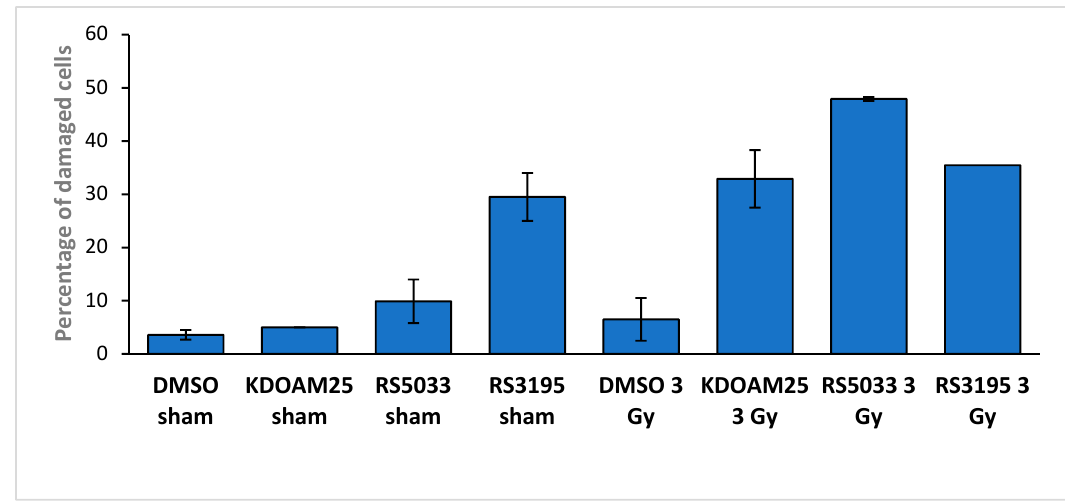
Figure 6. KDM5 enzymes inhibitors increase DNA damage accumulation in irradiated breast cancer cells. The histograms report the % fraction of MCF-7 cells showing a tail long at least as the head diameter in the described conditions. Concentrations were: 3 µ M for RS3195 and RS5033 and 0.3 µ M for KDOAM-25. DMSO concentration was 0.1% in all samples Data are the average of two independent experiments, variability is indicated (number of observed cells: DMSO sham 54; KDOAM-25 sham 40; RS5033 sham 44; RS3195 sham 98; DMSO 3 Gy 51; KDOAM 3 Gy 68; RS5033 3 Gy 50; RS3195 3 Gy 110).